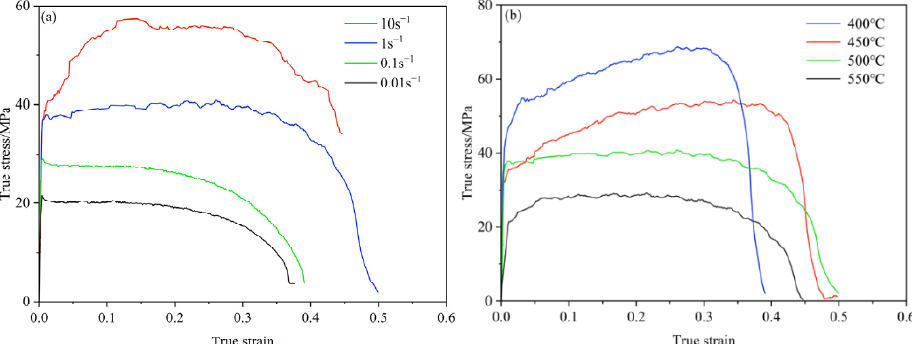
Figure 3. The stress–strain curve of 6016 aluminum alloy under different conditions. ( a ) The defor- mation temperature is 500 °C; ( b ) the strain rate is 1 s − 1 .